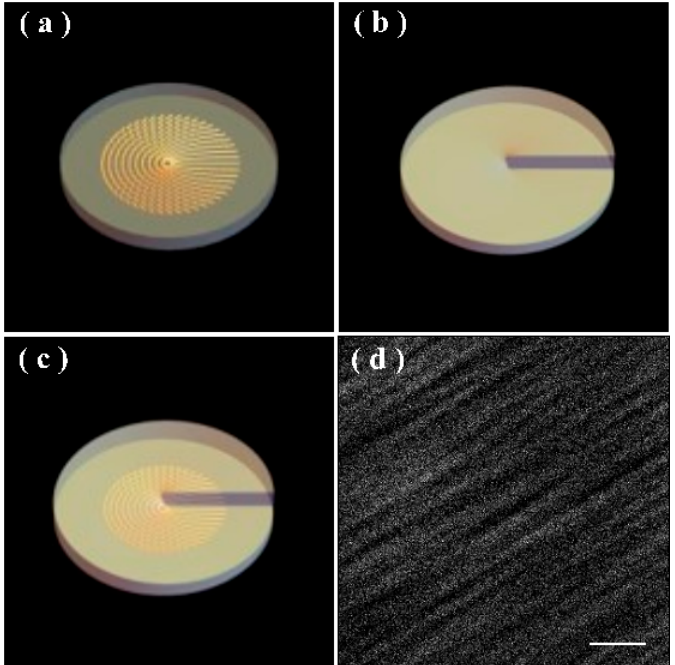
Figure 1. Schematic illustration of ( a ) the metasurface q-plate, ( b ) the spiral phase plate, and ( c ) the integrated glass vector-vortex plate. ( d ) The SEM image of the designed metasurface nanostructures, scale bar, 200 nm.